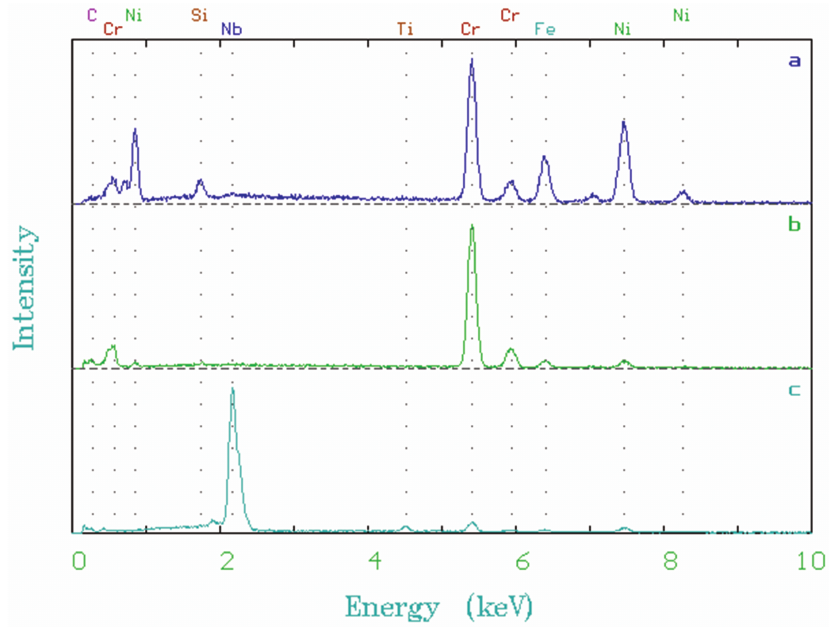
Figure 3: EDX spectra of selected area analyses of the matrix (a) and the dark (b) and light carbides (c) in the as-cast alloy.